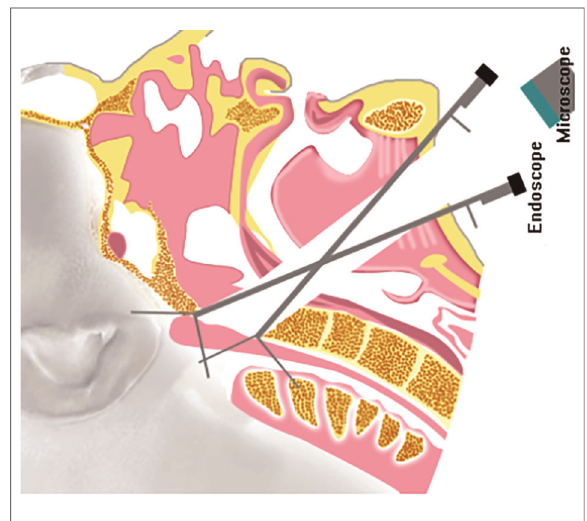
FIGURE 6 The comparison of the high anterior cervical approach to the craniovertebral junction under the endoscope and